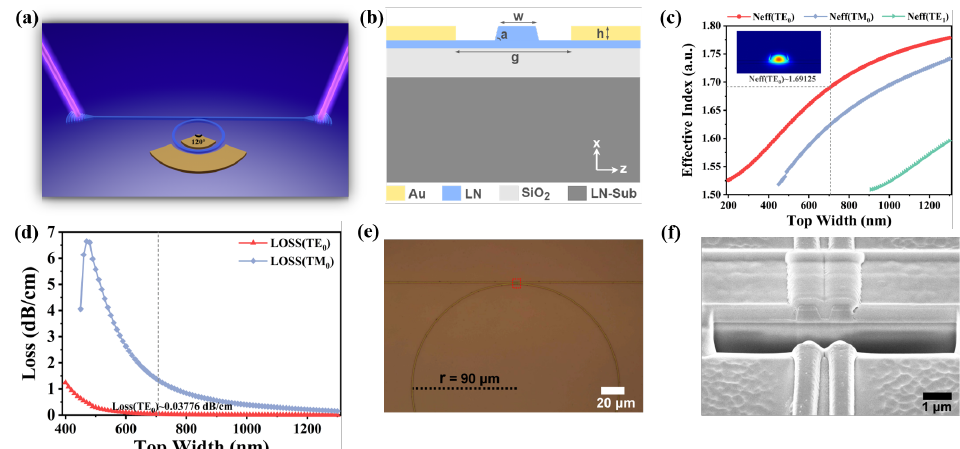
Figure 1. Design of the microring resonator. ( a ) Device diagram, showing the optical fiber, grating coupler, microring resonator and electrodes. ( b ) Waveguide design of microring resonator. ( c ) Effec- tive refractive index of waveguide modes at different top widths; the inset shows the TE 0 mode of the waveguide at 1550 nm. ( d ) Losses of TE 0 mode and TM 0 mode for different top widths. ( e ) A partial SEM image of the microring resonator; the figure contains part of the line waveguide and the ring waveguide and the radius of the microring resonator is 90 µ m. ( f ) SEM cross-sectional image of the microring resonator coupling region, corresponding to the region in the red dashed box in ( e